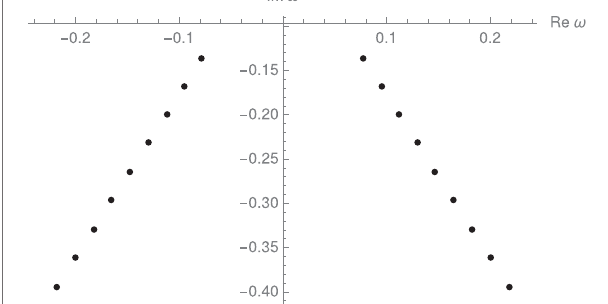
FIGURE2| Forthe fi rstfiveQNFsoftheKlein-Gordon fi eldweshowhow the imaginary part depends on the mass of the fi eld. We consider a 2D black hole (2) of radius r + (cid:1) 70.